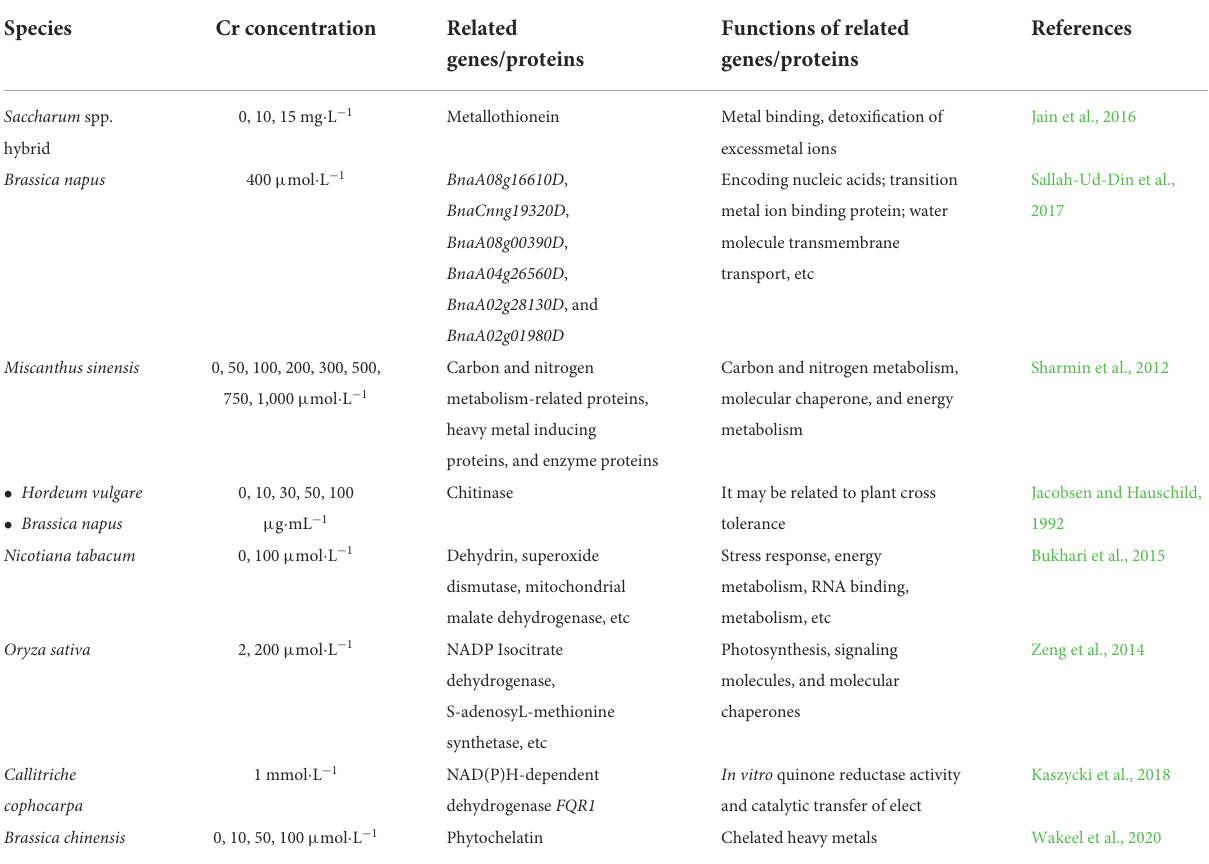
TABLE 4 Related genes or proteins induced by chromium treatment in